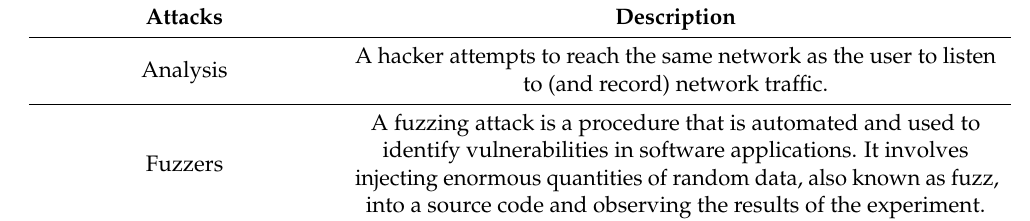
Table 1. All attack datasets; the dataset has 9 attacks and a normal case.